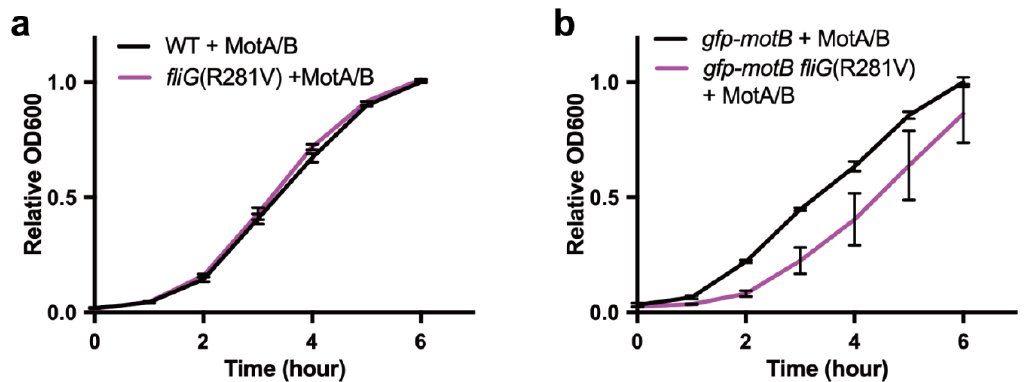
Figure 2. Multicopy effect of the MotA/MotB complex on cell growth. ( a ) Growth curves of the wild-type strain SJW1103 carrying pYC20 (WT + MotA/B, black line) and YVM046 carrying pYC20 ( fliG(R281V) + MotA/B, magenta line). The values of the optical density at 600 nm were normalized and obtained at 6 h in SJW1103/pYC20. ( b ) Growth curves of the YVM003 carrying pYC20 ( gfp-motB + MotA/B, black line) and YVM034 carrying pYC20 ( gfp-motB fliG(R281V ) + MotA/B, magenta line). The values of the optical density were normalized and obtained at 6 h in YVM003/pYC20. The cells were grown in LB medium containing 0.2% arabinose and 100 µg/mL ampicillin at 30 °C with shaking. Error bars represent standard deviations.